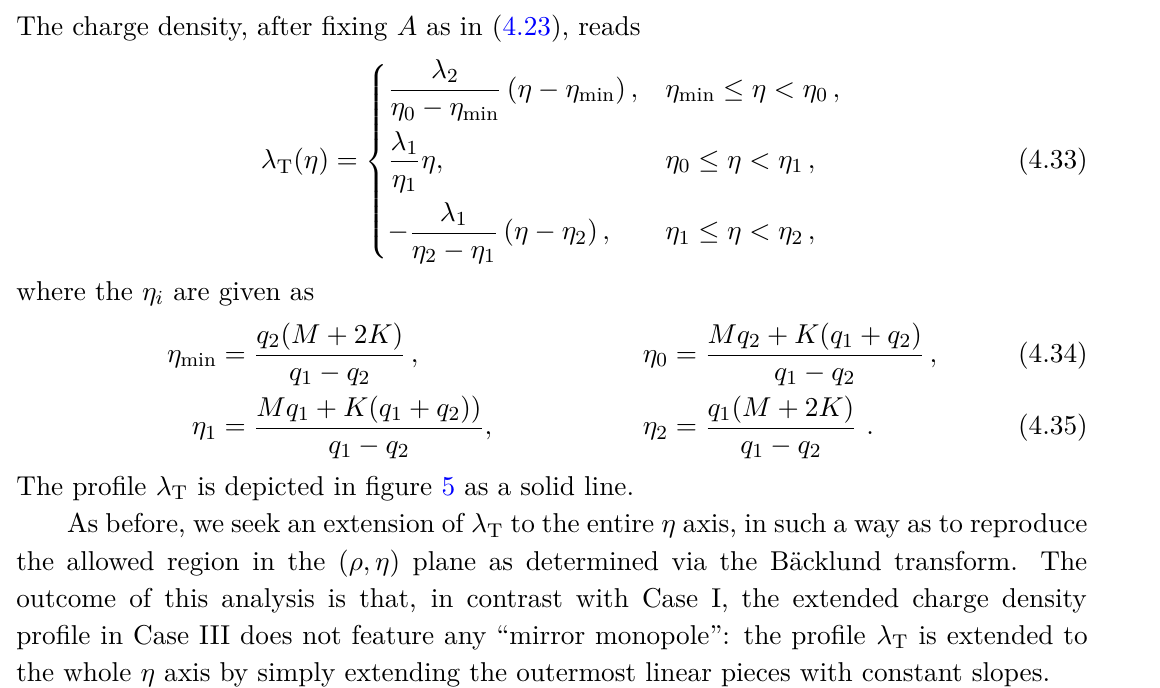
Figure 4. The allowed regions in the ( ρ, η ) plane for Cases I, IV, and V respectively. The solid red Figure 4 : The allowed regions in the ( ⇢ , ⌘ ) plane for Cases I, IV, and V respectively. The arcs signify the loci where ∂ = 0 , while the dashed red lines represent the loci where ∂ 2 V = 0 . solid red arcs signify the loci where @ ⇢ V = 0 , while the dashed red lines represent the loci ρ V η The similarity with figures 1, 2 is intentional, as the solid and dashed lines in each figure correspond where @ 2 ⌘ V = 0 . The similarity with Figures 1, 2 is intentional, as the solid and dashed lines to one another. As the combination t goes from positive to negative, we transition from 1 u 2 − u 1 t 2 u 1 t 2 goes from positive in each figure correspond to one another. As the combination t 1 u 2 Case V to Case III. The red dashed arc of Case V shrinks and is replaced by the second monopole  to negative, we transition from Case V to Case III. The red dashed arc of Case V shrinks and present in Case is replaced by the second monopole present in Case III. FB Put labels I, IV, V on the three plots